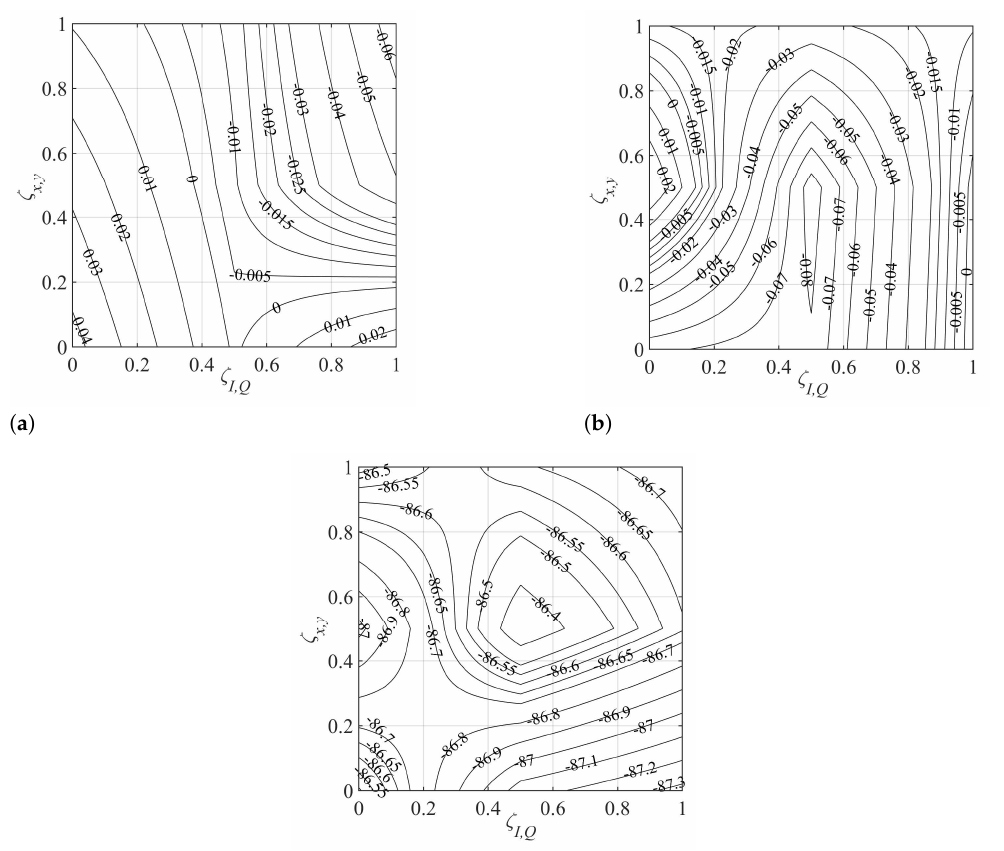
Figure 7. ( a ) Normalized mean of the I component of the ICXT field in the y direction at the interfered core output; ( b ) correlation coefficient between the I component of the ICXT field in the y direction and the Q component of the ICXT field in the y direction at the interfered core output; and ( c ) mean power of the I component of the ICXT field in the y direction at the interfered core output (in dB) for (cid:0) ∆ (cid:1) β c, mn = − 701rad·m − 1 quasi-homogeneous WC-MCF with L C = 10m and L B = 10m (regime L C ≈ L B